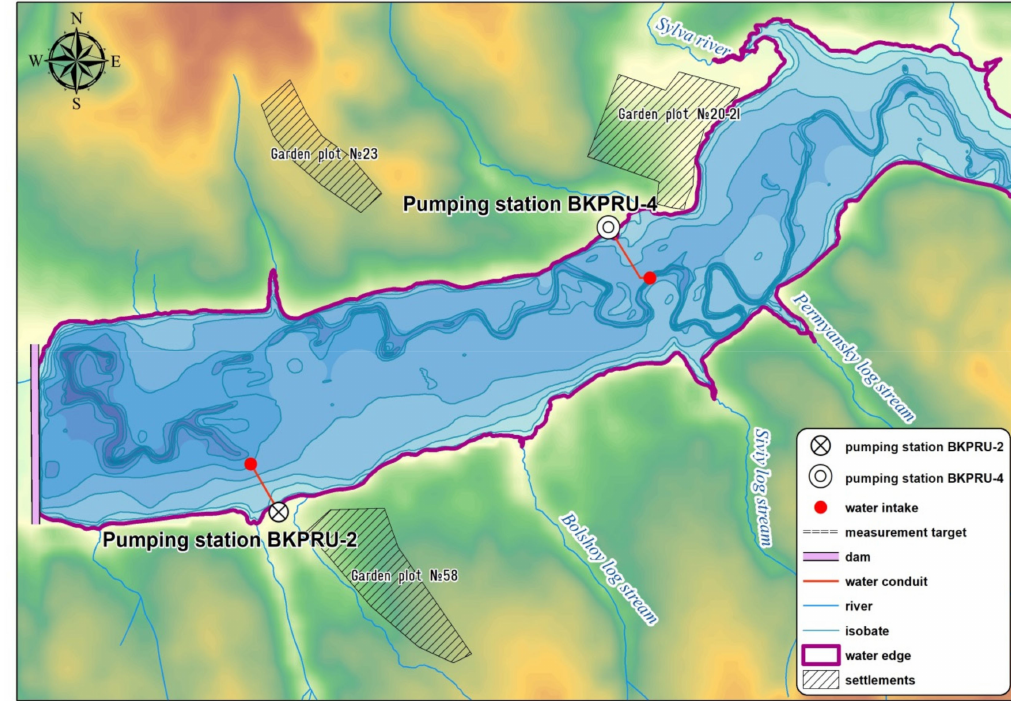
Figure 3. Distribution of depths in the water area of the Verkhne-Zyryansk reservoir according to the bathymetric survey data of the Mining Institute of the Ural Branch of the Russian Academy of